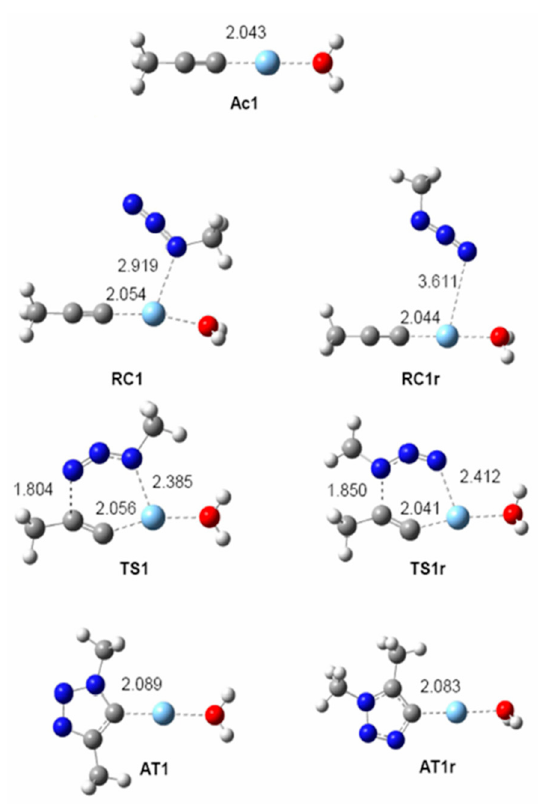
Figure 7. Optimized geometries (in water) of the stationary points associated with the mononuclear AgAAC reaction of Ac1 with 5 . Distances are given in Å.